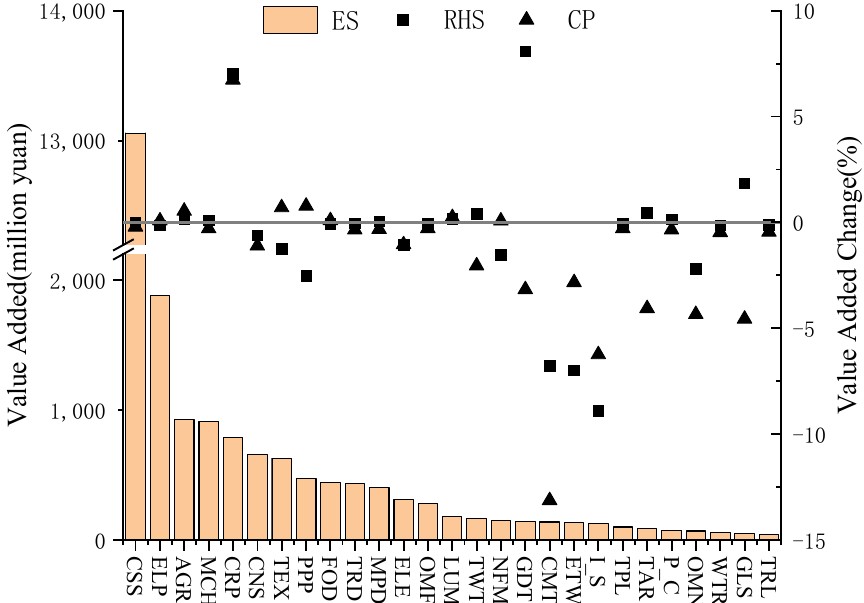
Figure 7. Value added of ES scenarios in 2035 (left y-axis) and value add changes in the RHS scenario and CP scenario compared with the ES scenario (right y-axis).